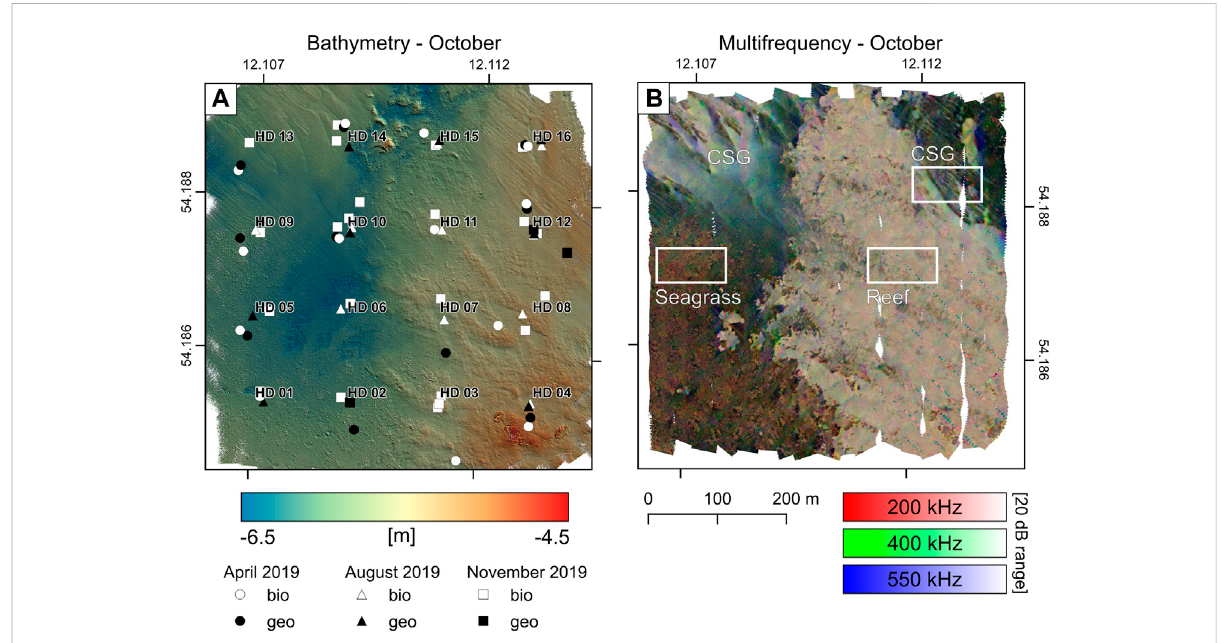
FIGURE 2 (A) Hillshaded (sun azimuth of 35 ° , sun elevation of 20 ° ) bathymetry of the working area recorded in October 2019 at 400 kHz frequency. The position of grab samples for biological and sedimentological (Table 2) analysis is indicated around the planned stations (HD01 to HD16). (B) Multifrequencybackscattermap(200,400,and 550 kHz)recordedinOctober 2019.Thethreeidenti fi edfaciesandthepositionsofdetailed viewsin Figure 4(reef),Figure 7(CSG),and Figure 8(seagrass)areindicated.The combinationofthebackscatter mapsofdifferentfrequencies usingthe three channels of a false-color image allows for an easy, visible distinction of the present